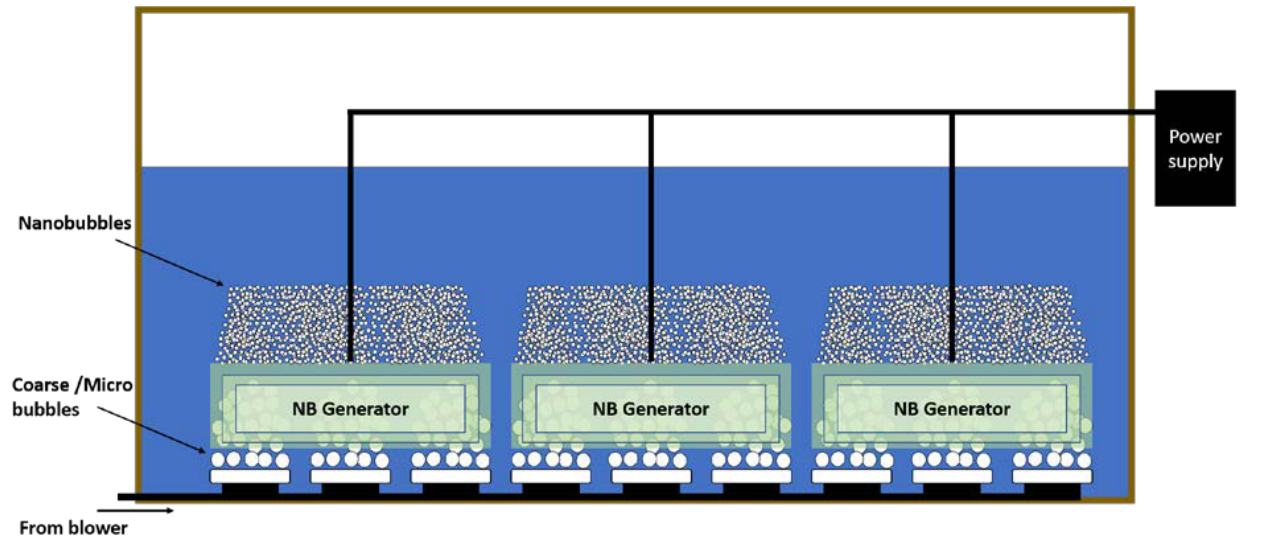
Figure 3. Retro-fit of the water-aeration tank with an existing bank of air diffusers. Image credit: M.R. Ghaani.